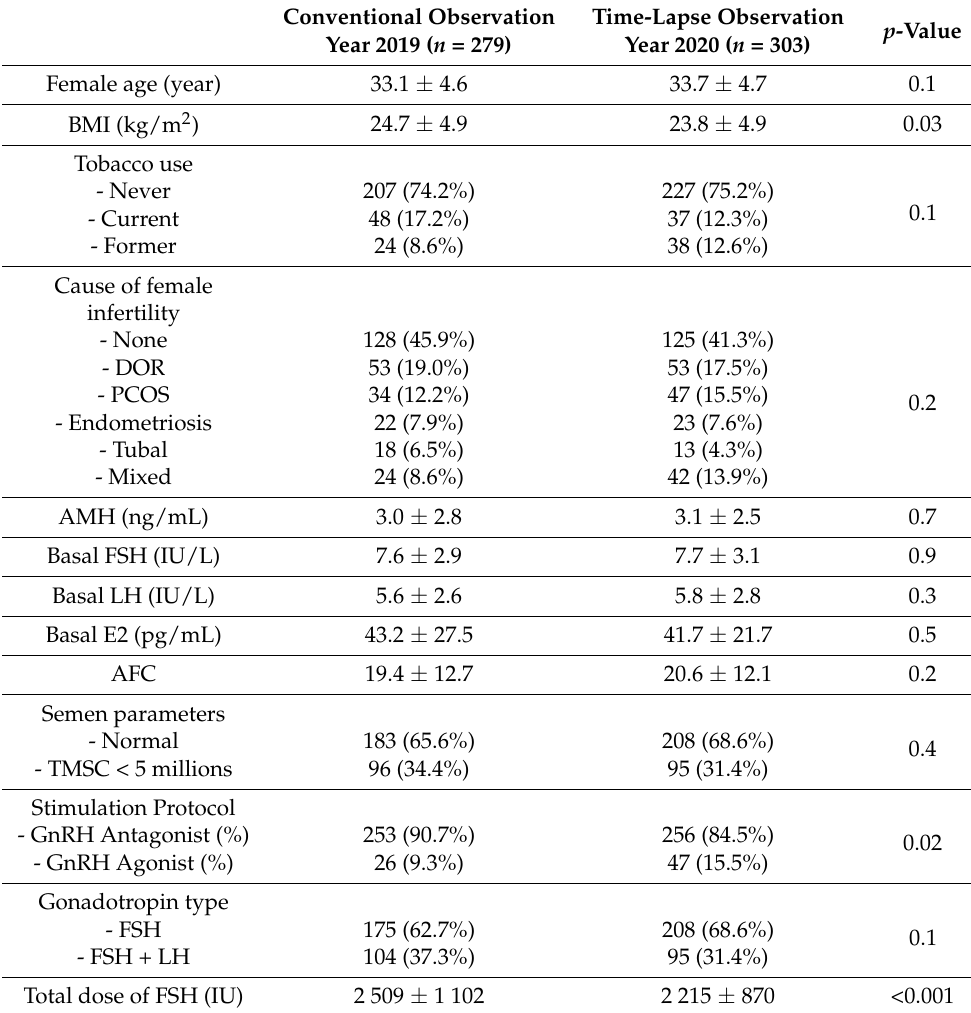
Table 3. Baseline characteristics and stimulation parameters in the conventional observation group (2019), and the time-lapse observation group (2020). Values are shown as mean ± SD or n